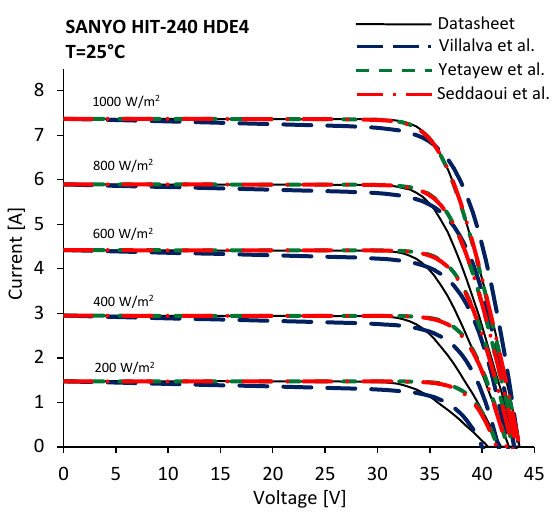
Figure 8. Comparison between the issued I-V characteristics of Sanyo HIT-240 HDE4 at T = 25 °C and the characteristics calculated by means of the Villalva et al ., the Yetayew et al . and the Seddaoui et al . models.